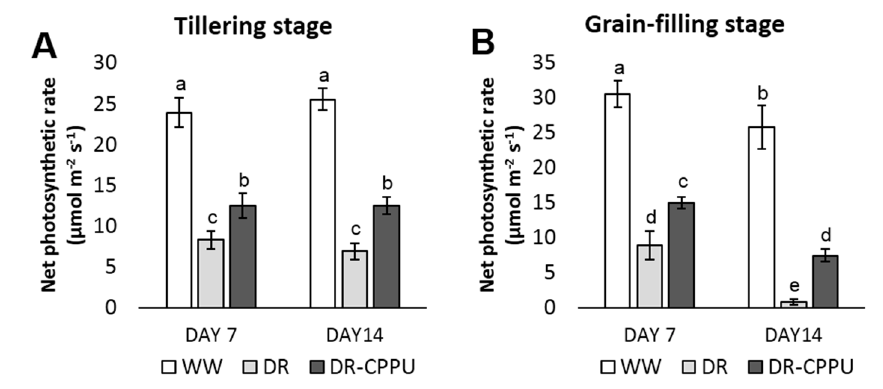
Figure 9. Net photosynthetic rate (µmol m − 2 s − 1 ), measured from rice leaves under different treatment conditions at the tillering ( A ) and grain-filling ( B ) stages. WW = Well-watered plants (soil moisture tension of − 15 kPa), DR = Drought stressed plants (Soil moisture tension of − 55 kPa and − 72 kPa at day 7 and day 14, respectively), and DR-CPPU = Drought stressed plants, sprayed with 5 mg / L CPPU on day 6 of drought treatment. Error bars represent SD (standard deviation). Letters viz. a, b, c, d, e, over SD bars indicate the highly significant differences of mean at p < 0.01 (**), as analyzed by Duncan’s Multiple Range Test (DMRT).